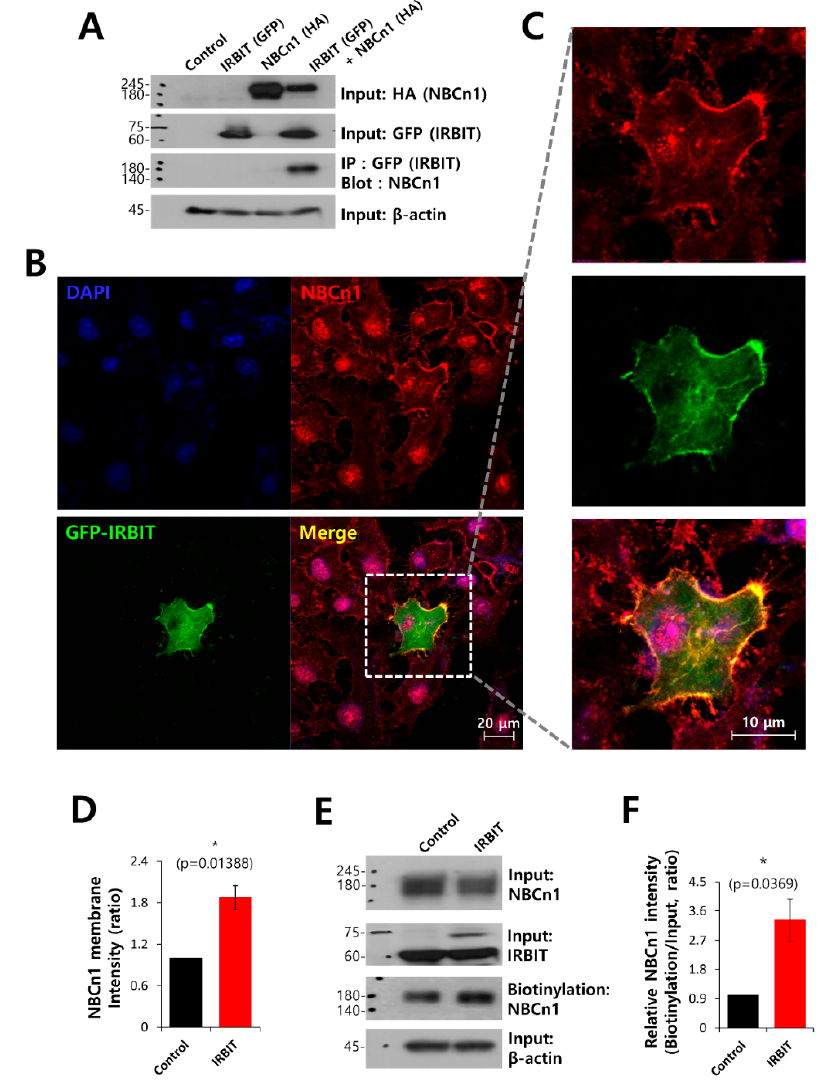
Figure 2. IRBIT co-localized with NBCn1 and modulated the membrane expression of NBCn1. ( A ) Co-IP of NBCn1 and IRBIT in HEK293T cells. Cells were transfected with HA-tagged NBCn1 and GFP-tagged IRBIT, immunoprecipitated with GFP antibody, and blotted with NBCn1 antibody. β -Actin, input HA, and input GFP blots were used as loading controls ( n = 3). ( B ) Immunostaining images